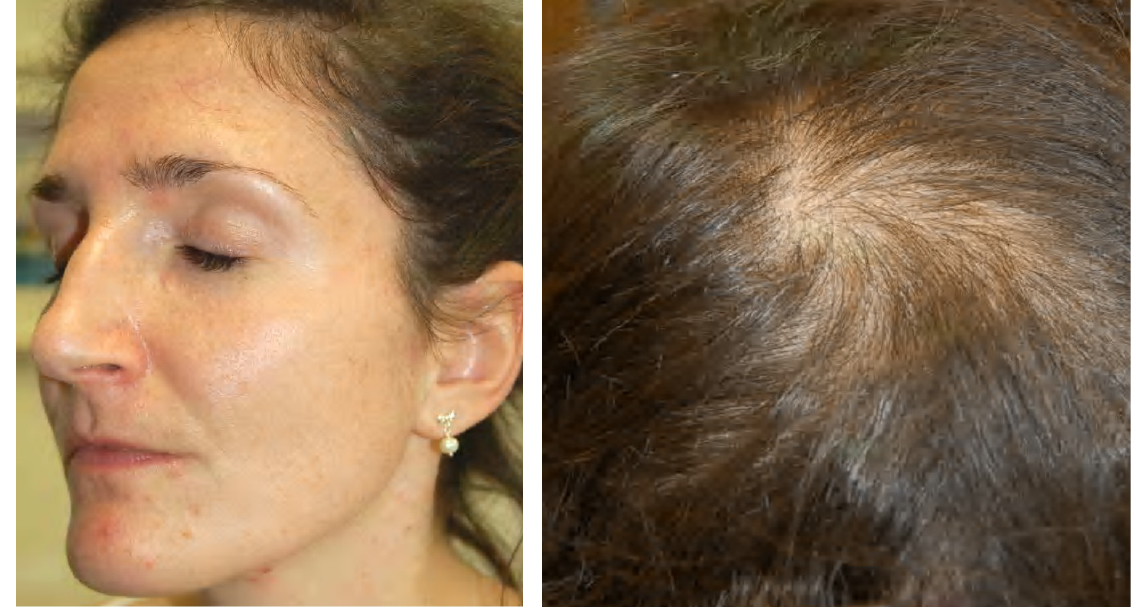
Figure 4. A 30-year-old female patient with primary ovarian insufficiency. Clinical signs: Amenorrhea, seborrhea, acne tarda and male-pattern baldness. Reproduced from Zouboulis et al. [107] with permission from S. Karger AG, Basel.